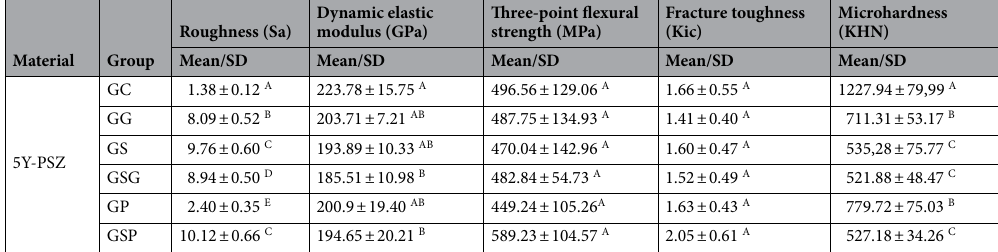
Table 1. Means and standard deviation and the statistical differences after Tukey’s test corresponding to the mechanical properties of the 5Y-PSZ. *Different letters indicate statistically significant differences between lines. * SD Standard deviation.